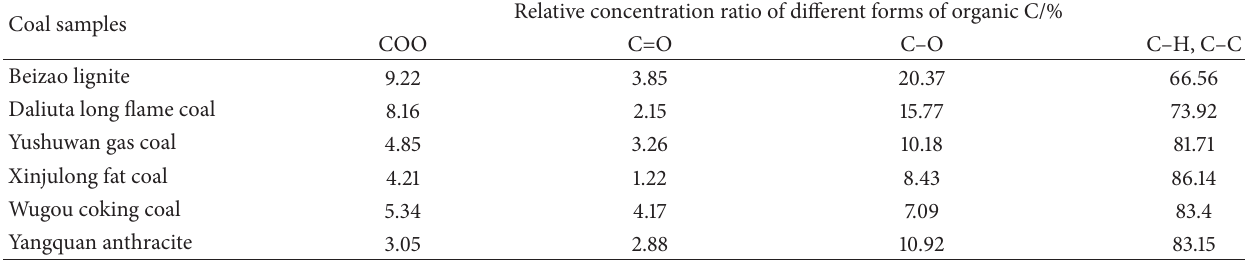
Table 3: Ownership and content of organic carbon of different coal samples.